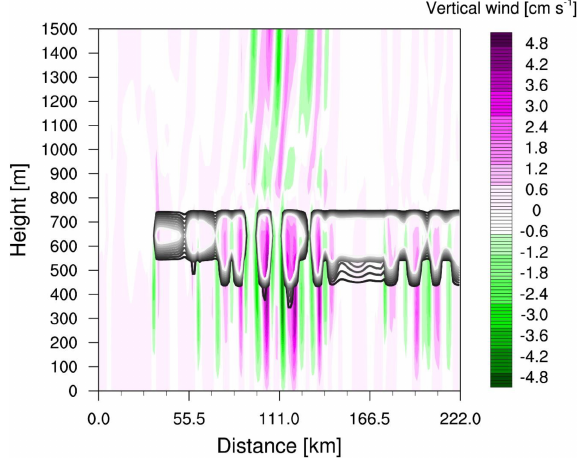
Figure 23. Modeled 2D vertical wind field on 5 October after 12h of simulation time. The model domain spans 222km of length and 1.5km of height. The black contour lines represent the simulated cloud liquid water content (with a minimum of 0.01gm − 3 and a maximum of 0.5gm − 3 ). The more dense the lines, the higher the simulated liquid water content of the